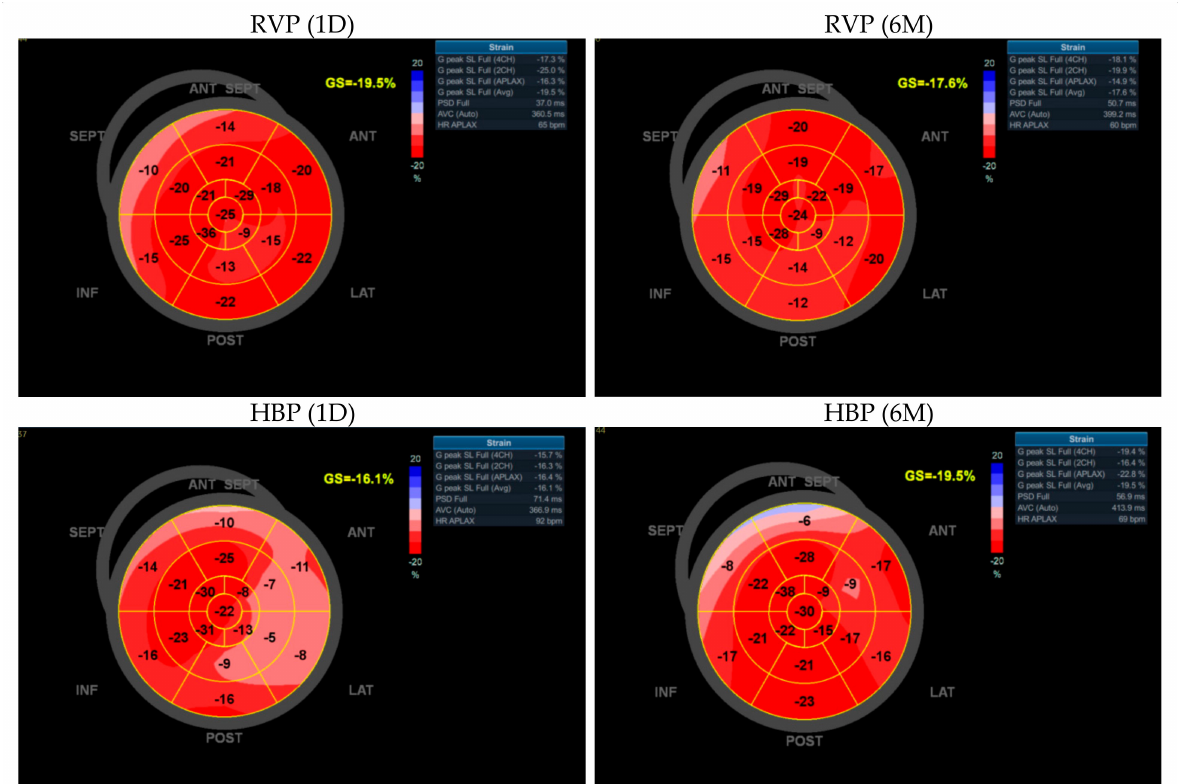
Figure 3. Echocardiographic assessment of left ventricular function using 2D speckle-tracking technique: bull’s eye diagram of global longitudinal strain and peak systolic dispersion of selected patients with right ventricular pacing (RVP) and His bundle pacing (HBP) obtained immediately after pacemaker implantation (1D) and at 6-month follow-up visit